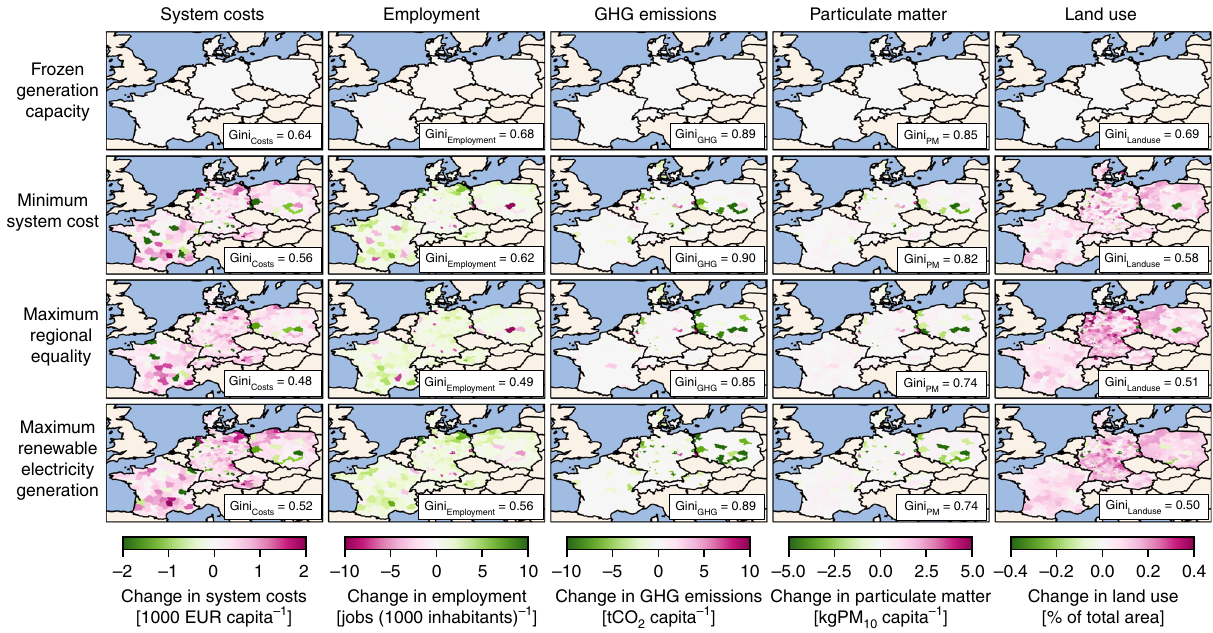
Fig. 4 Regional impacts from generation, storage, and transmission in 2035. The values show changes in system costs, employment, greenhouse gas (GHG) emissions, particulate matter emissions, and land use per NUTS-3 region for the four distinct scenarios of frozen generation capacity, minimum system costs, maximum regional equality of system costs, and maximum renewable electricity generation, as compared to the scenario with frozen generation capacity that represents the electricity system infrastructure from 2018. A Gini index of 1.0 indicates perfect regional inequality and a Gini index of 0.0 indicates perfect regional equality. In the scenarios of minimum system cost, maximum regional equality of system costs, and maximum renewable electricity generation, each country meets its national electricity generation targets for 2035 (see “ Methods ” ). System costs include annual capital and variable costs (i.e., fuel, operation, and maintenance) for electricity generation, storage, and transmission. Employment impact includes annual direct employment for electricity generation and storage, including jobs in construction, installation, operation, maintenance, and decommissioning. For